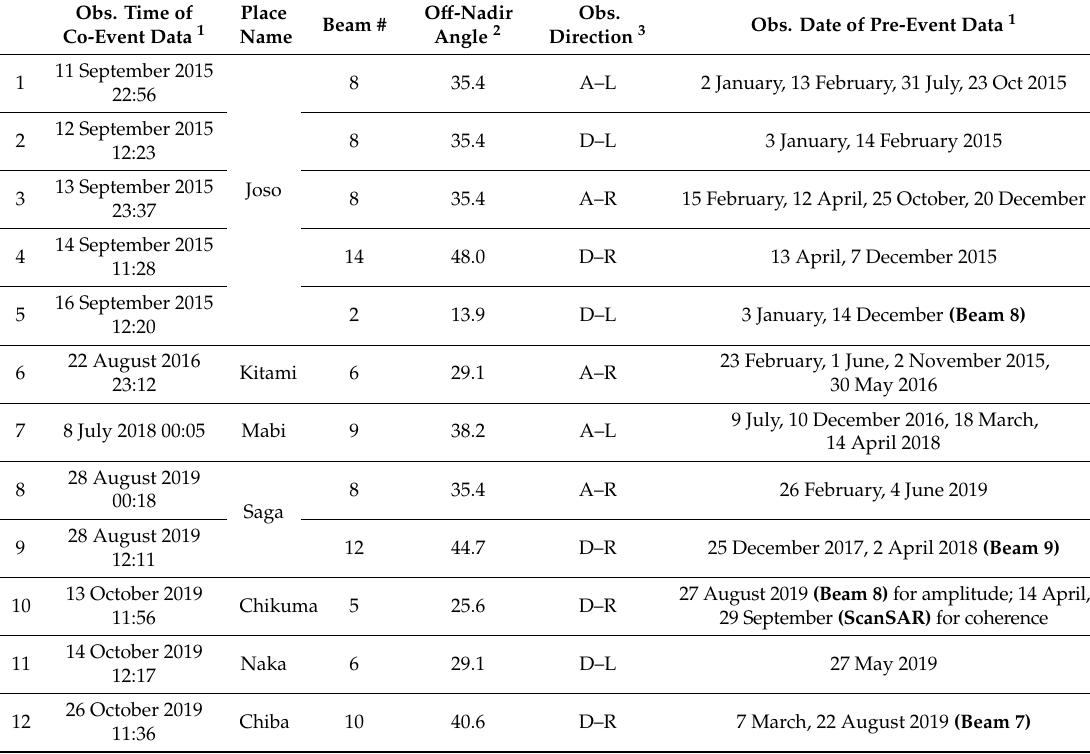
Table 1. The Advanced Land Observing Satellite-2 (ALOS-2) test data used in this